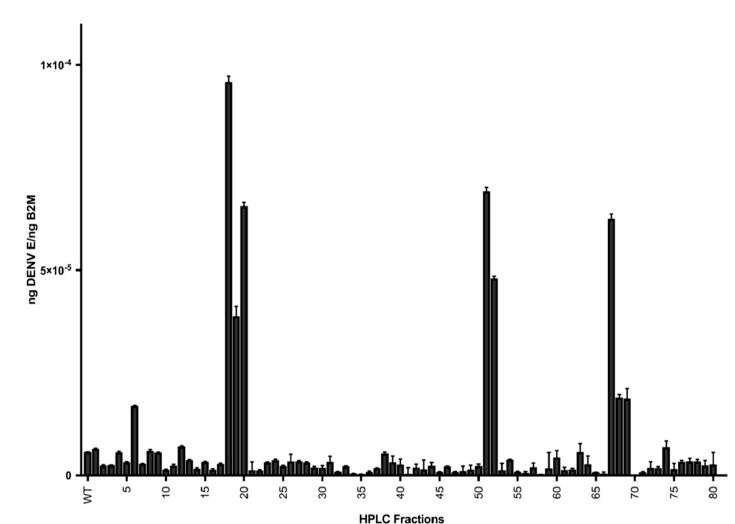
Figure 2. Human primary dermal fibroblast cells were simultaneously treated with 80 Aedes aegypti saliva fractions and infected with DENV-2. Wild-type (WT) cells were treated with whole saliva and DENV-2, instead of saliva fractions. Then, 24 h post-infection, the cells were lysed and RNA was collected and used to quantify the DENV viral load by qRT-PCR. Data presented are ng RNA, calculated using previously determined standard curves for DENV E mRNA and Human B2M mRNA. Results are the mean ± standard error of the mean of three independent